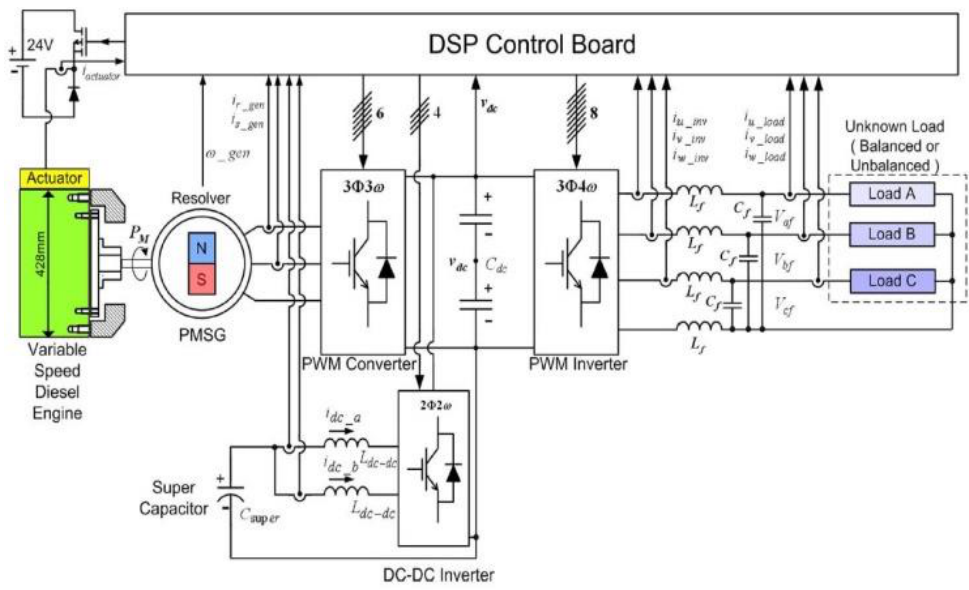
Figure 11. Configuration of VSDG using super capacitor [20].